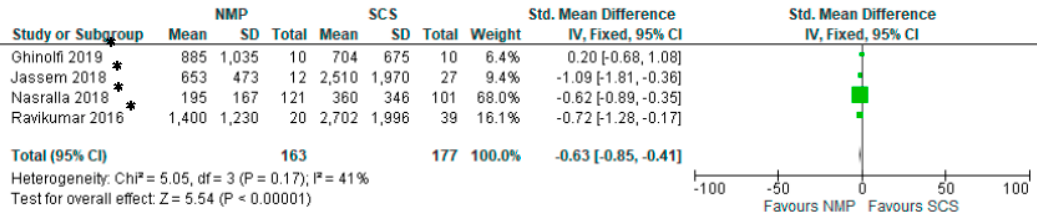
Figure 16. Peak serum AST in studies comparing HMP to SCS. In papers marked with “ * ”, mean and standard deviation were calculated using the method described by Wan 2014 [5].